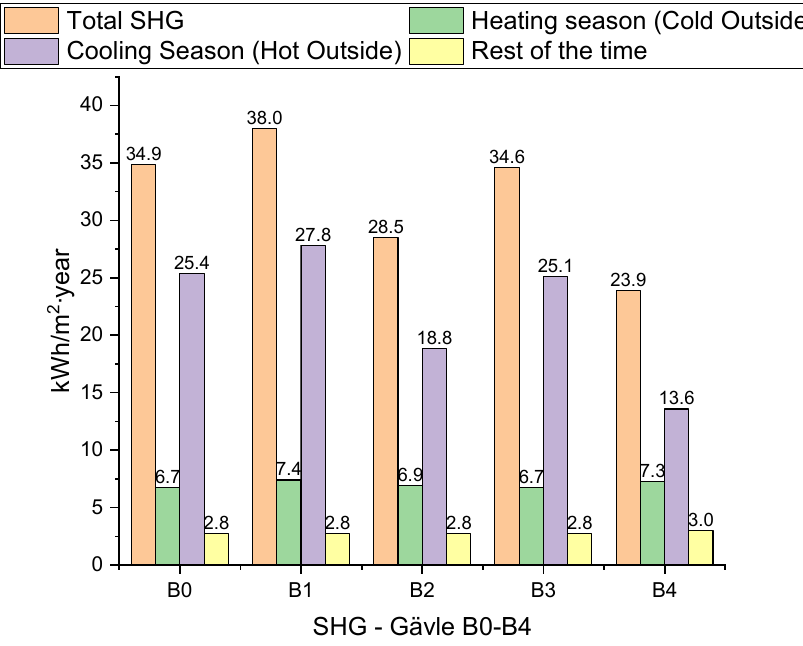
Figure 11. SHG for Gävle under effect of different parameters.